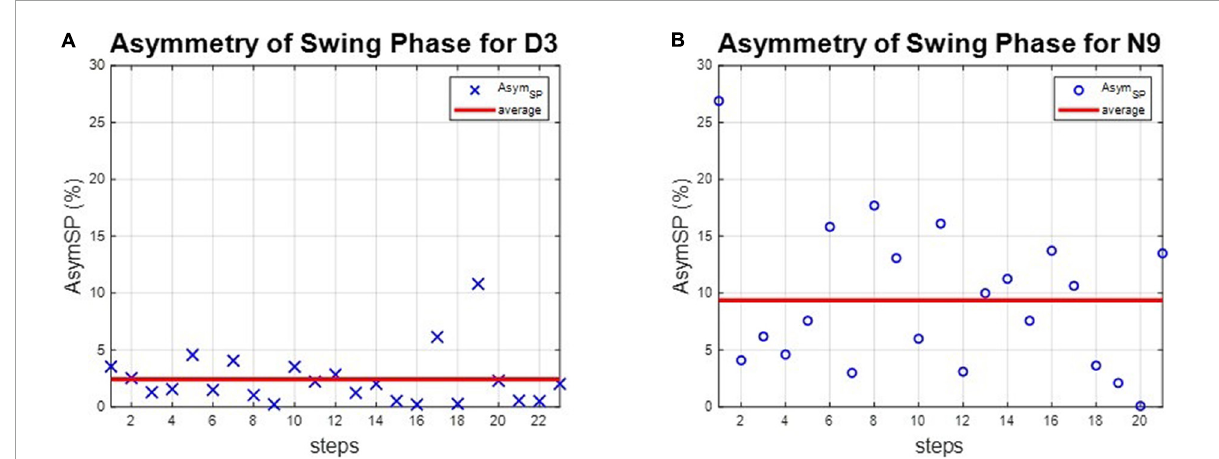
FIGURE5 The asymmetry of the swing phases of D3 and N9. The dancer tended to have smaller Asym SP than the non-dancer control, because of dance training. (A) The dancer D3. (B) The non-dancer control